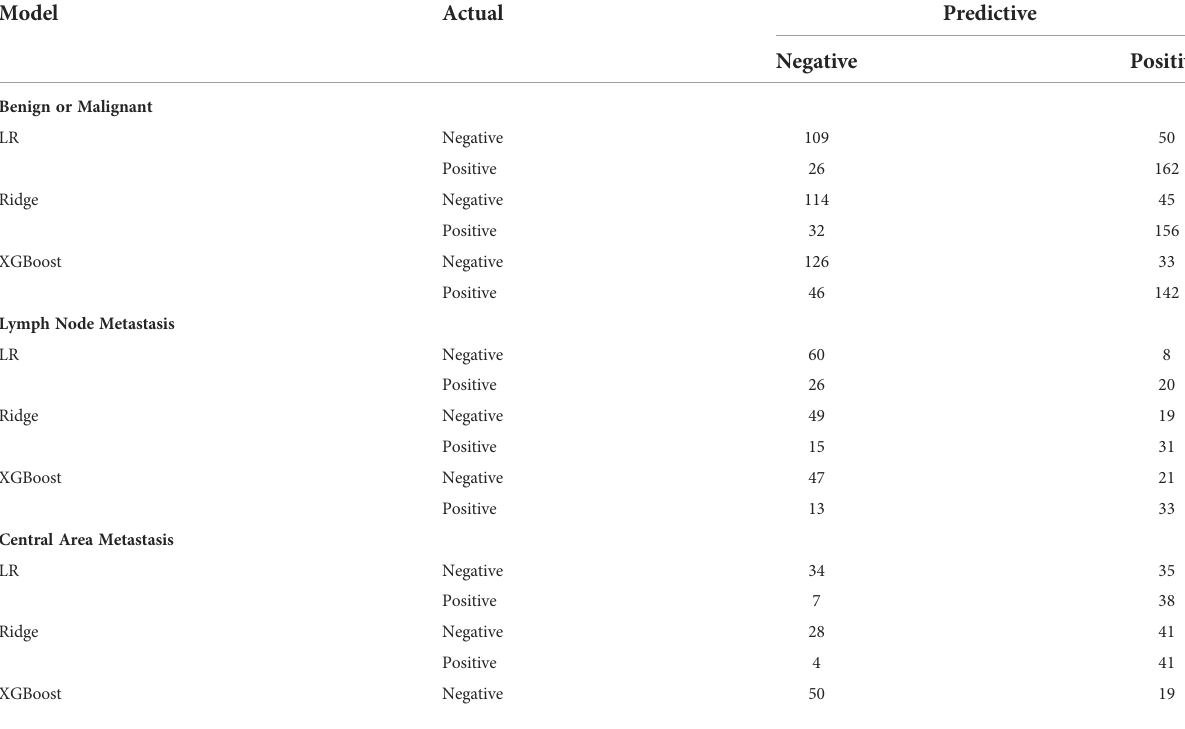
TABLE 3 Confusion matrices of predictive models.